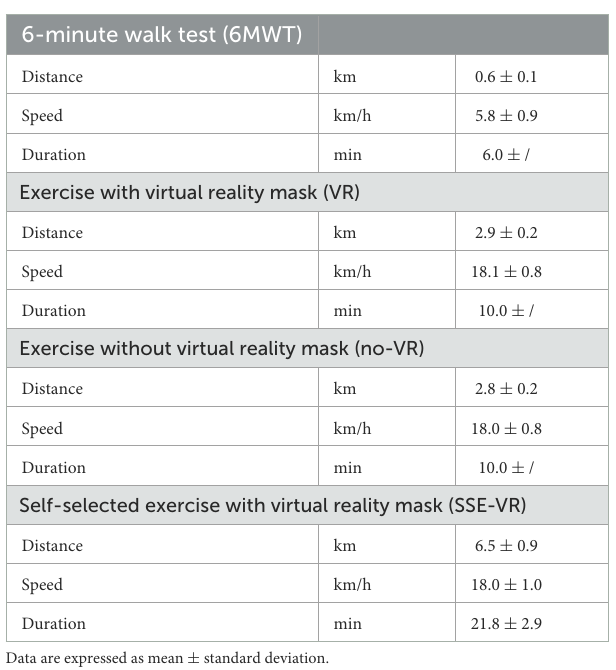
TABLE 1 Long-post-COVID-19 patient characteristics. TABLE 2 Exercise characteristics.